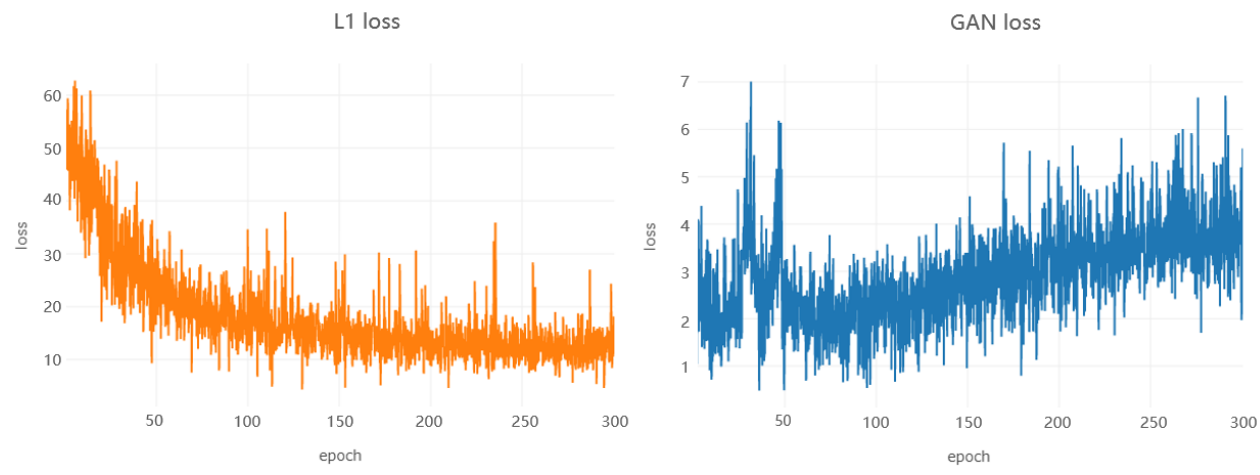
Figure 9. The curve of the L1 loss and GAN loss as epoch increased. Table 5. Performance of the model under different epochs.